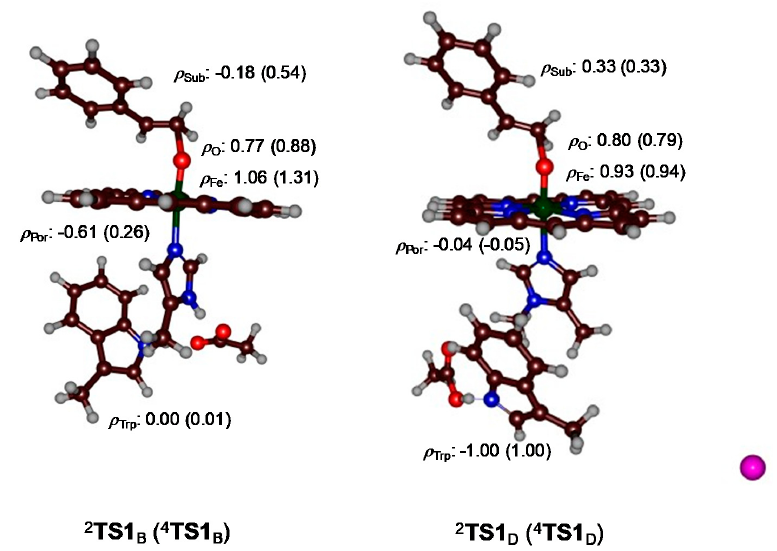
Figure 5. Group spin densities of UB3LYP/BS1 calculated transition states for styrene epoxidation by 2,4 B and 2,4 D as calculated in Gaussian-09.